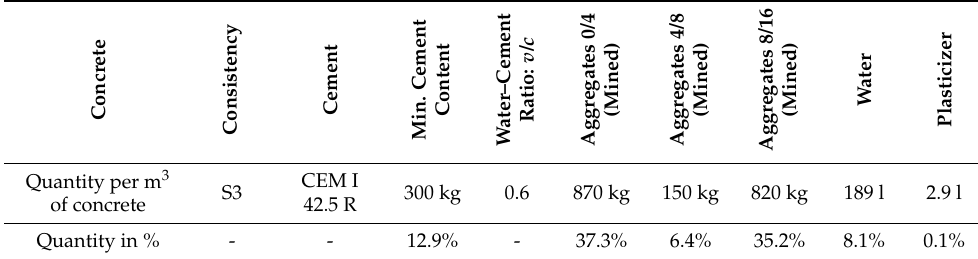
Table 1. Material properties of concrete for laboratory samples and slabs.